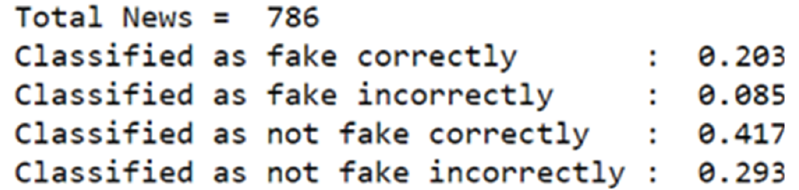
Figure 6. Result of authors’ credibility and stance detection.